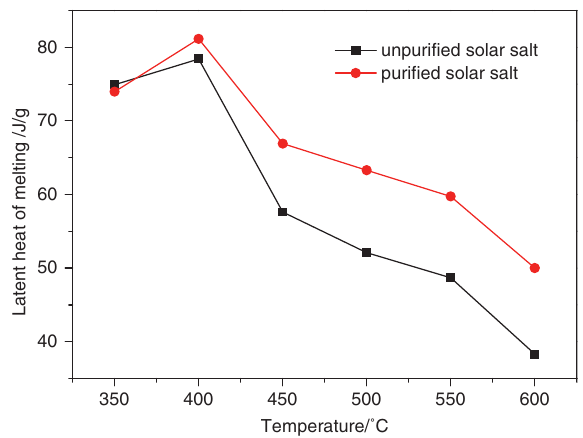
Figure 12: Thermogravimetric measurement results of sodium nitrate molten salt.